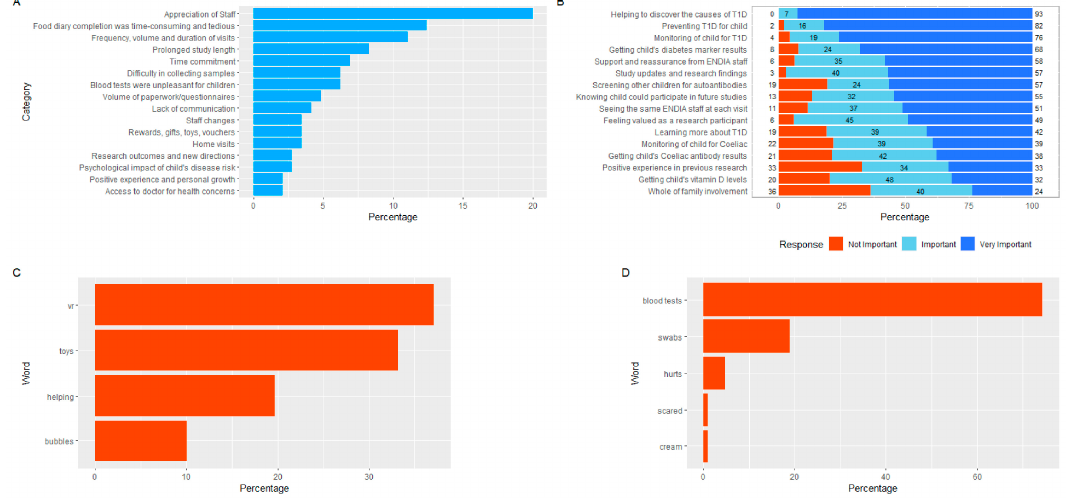
Figure 3. ( A ) Aspects of participation in ENDIA that caregivers found to be “surprising”, which reflect both positive and negative experiences. ( B ) Responses to “How important have the following reasons been for staying in ENDIA?” ( C ) Commonly reported “likes” from the Child Survey. ( D ) Commonly reported “dislikes” from the Child Survey.